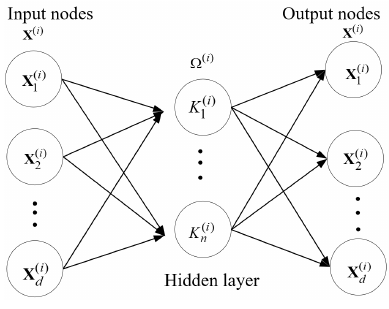
Figure 5. The structure of